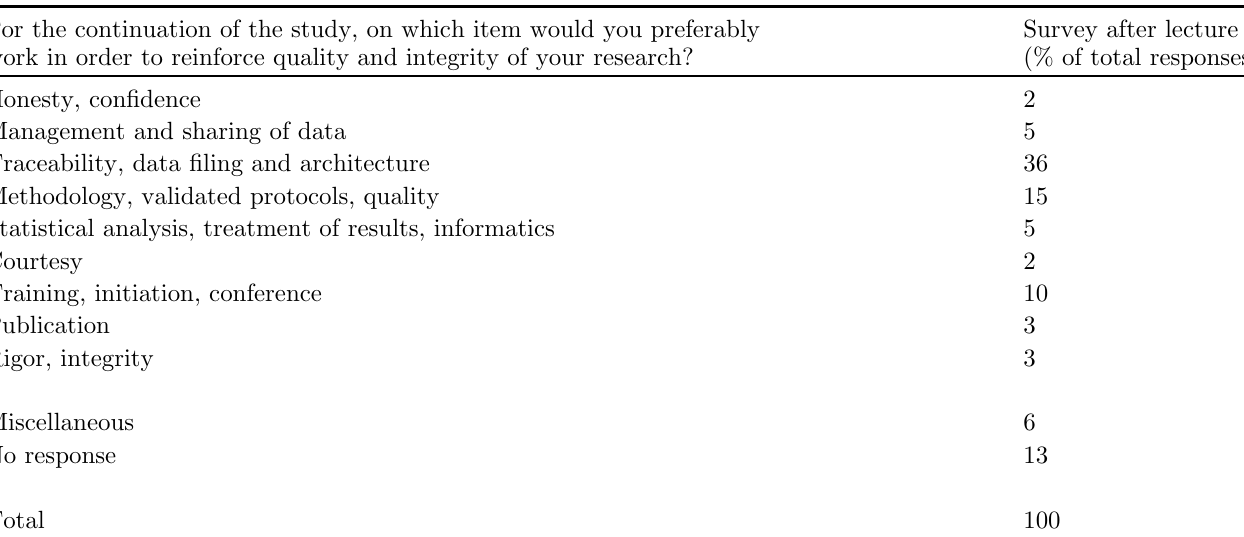
Fig. 5. Personal opinion on research integrity and quality in own work and in work of the other scientists in the lab. Table 2. Preferred problem to work